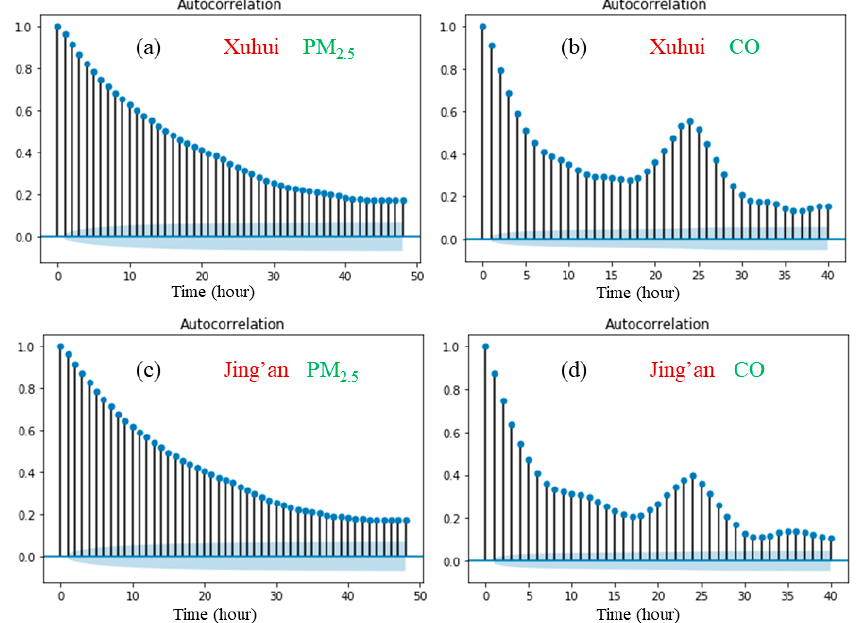
Figure 6. Autocorrelation function (with 95% confidence intervals) of hourly air quality data in the two monitoring stations. ( a ) Xuhui, PM 2.5 ( b ) Xuhui, CO ( c ) Jing’an, PM 2.5 ( d ) Jing’an, CO.